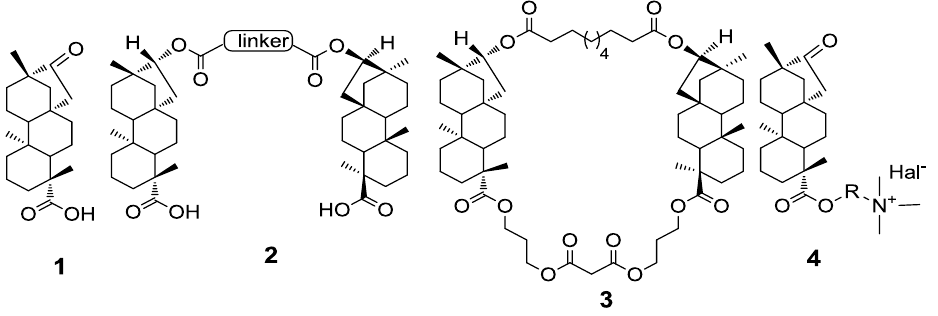
Figure 1. Isosteviol 1 and selected biological active